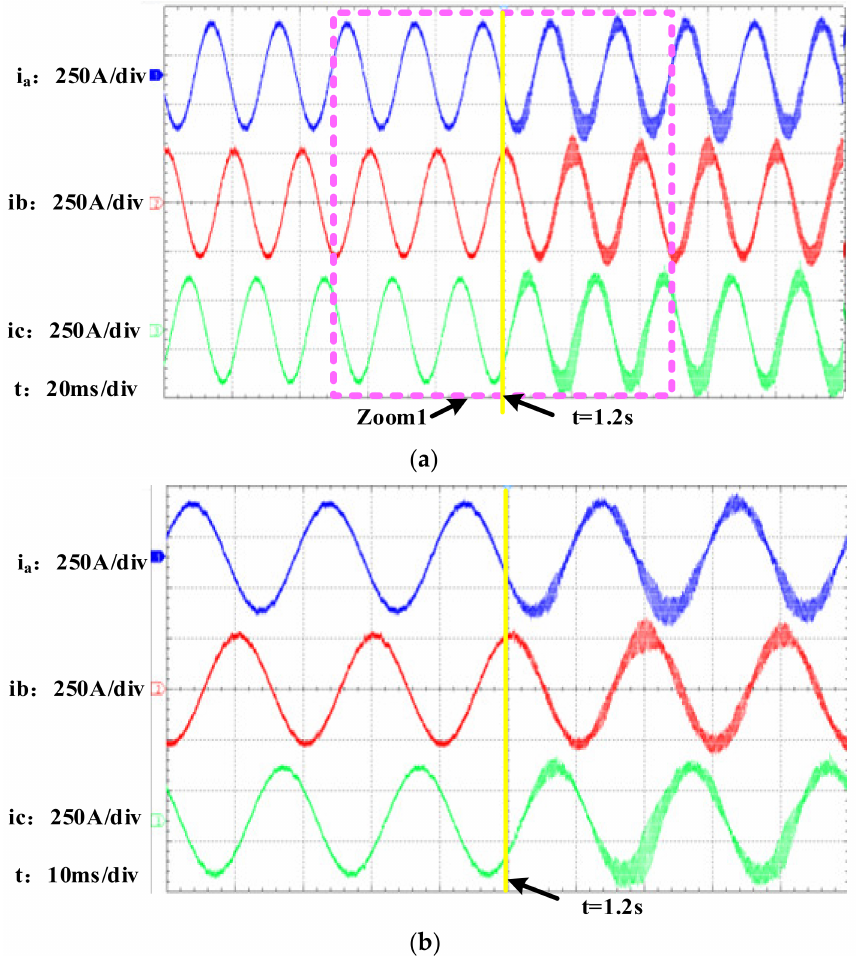
Figure 16. Photovoltaic cluster inverter from stable to dynamic resonant grid current waveform. ( a ) Without the proposed DOB; ( b ) the waveforms of Zoom